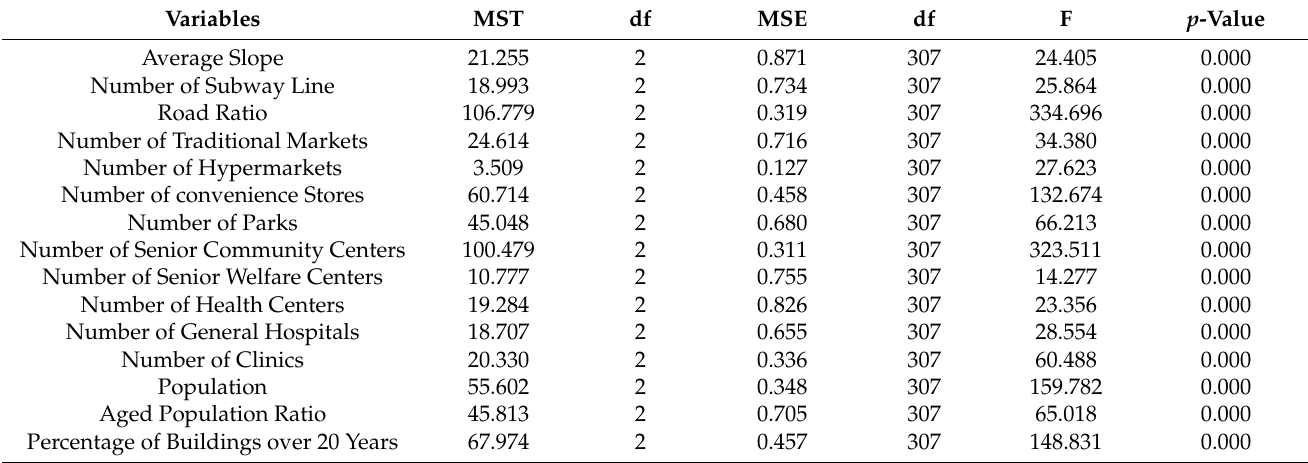
Table 10. Environmental characteristics of clusters (ANOVA